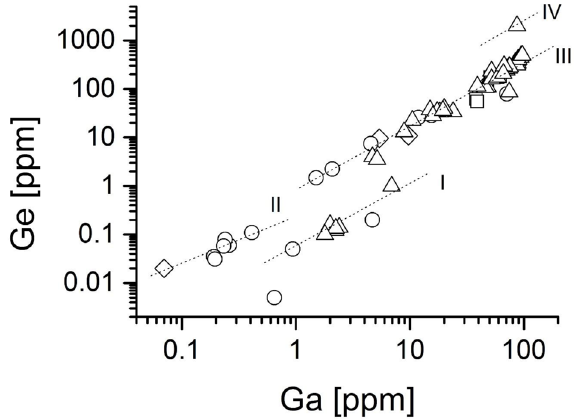
Figure 9. Logarithmic plot Cu against Ni for iron meteorites (data from Table 2, incl. dual-concentration values for Cu); Δ octahedrites, o hexahedites, ¡ ataxites, ◊ anomalous; Group I: ataxite Hoba (low Cu value); Group II: 3 ataxites with low Cu/ Ni ratio; Group III: main group with 7 H, 2 Of, 3 Off, 3 Om, 10 Og, 5 Ogg, 1 O, 6 ataxites, 1 anomalous; Group IV: 3 H, 1 Of, 3 Om, 1 Og, 2 Ogg, 1 ataxite (Table 4).